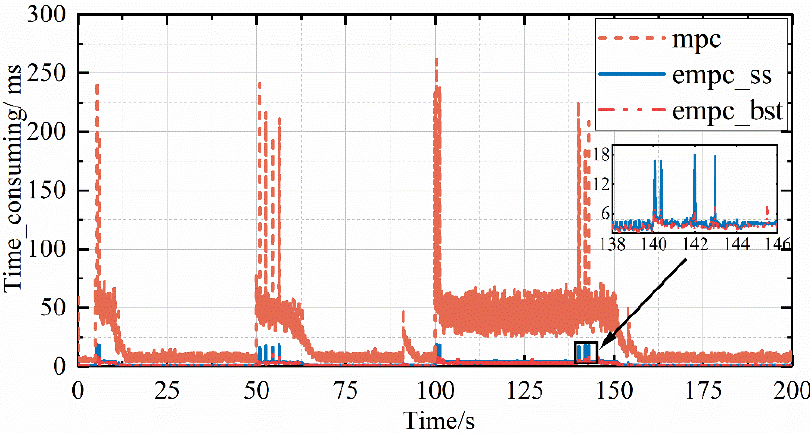
Figure 9. Comparison of time consumed between different controllers.